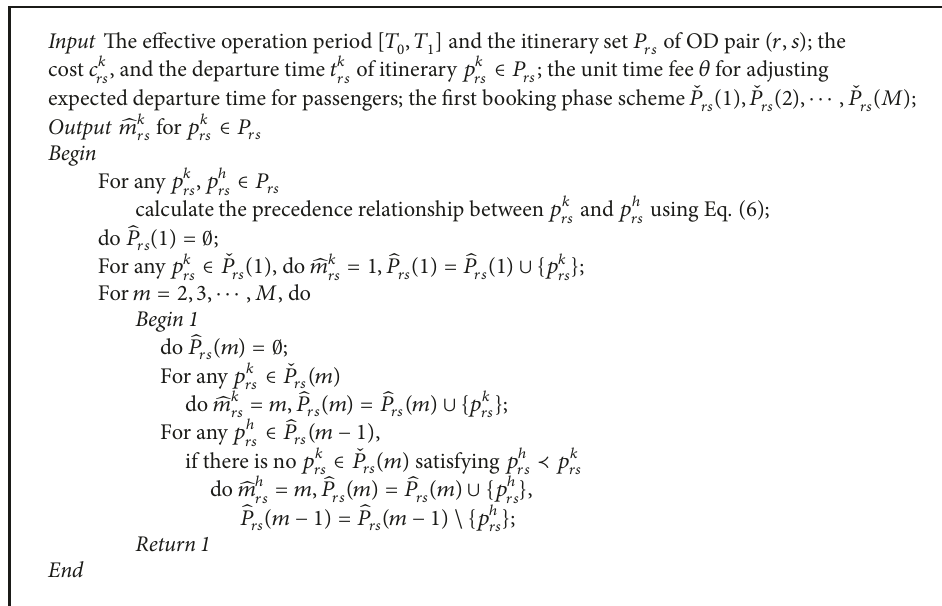
Algorithm 2: The Last Booking Phase Partition